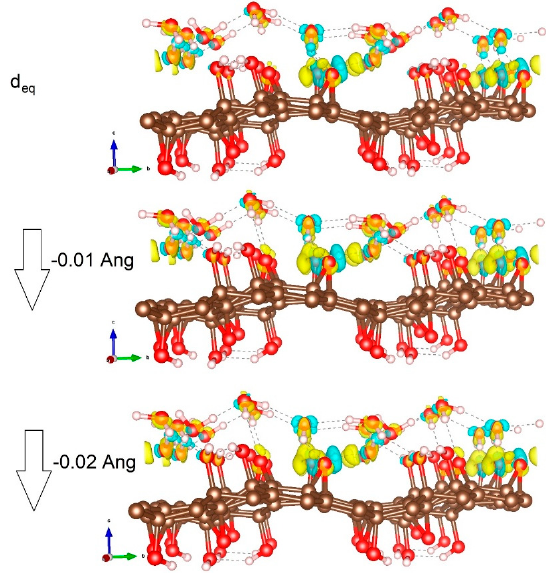
Figure 2. Charge distribution induced by the interface formation. Here, the charge is calculated as the difference between the charge distribution of the coupled structure minus the two contributions, H 2 O and GO layers, respectively, in their interacting geometry. [brown: C, red: O, and white: H atoms. Yellow and light blue isosurfaces are negative and positive charge distribution (isosurface level 0.005 e/Bohr 3 )].